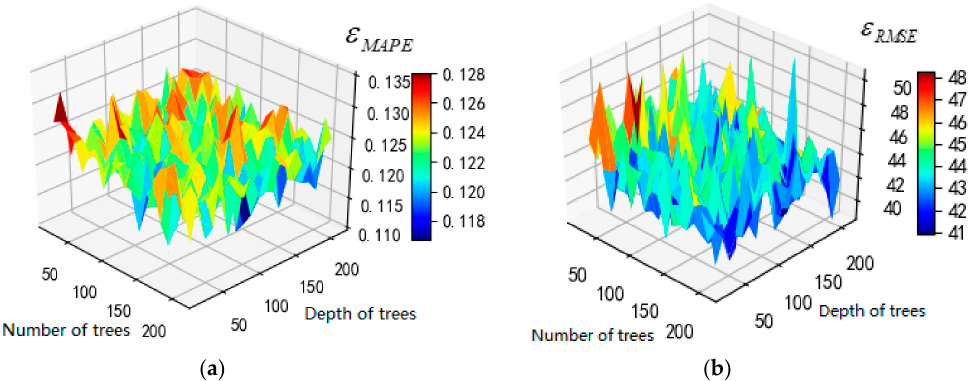
Figure 8. Relationship between forest structure and error by charging station group forecast: ( a ) ε MAPE ; and ( b ) ε RMSE .